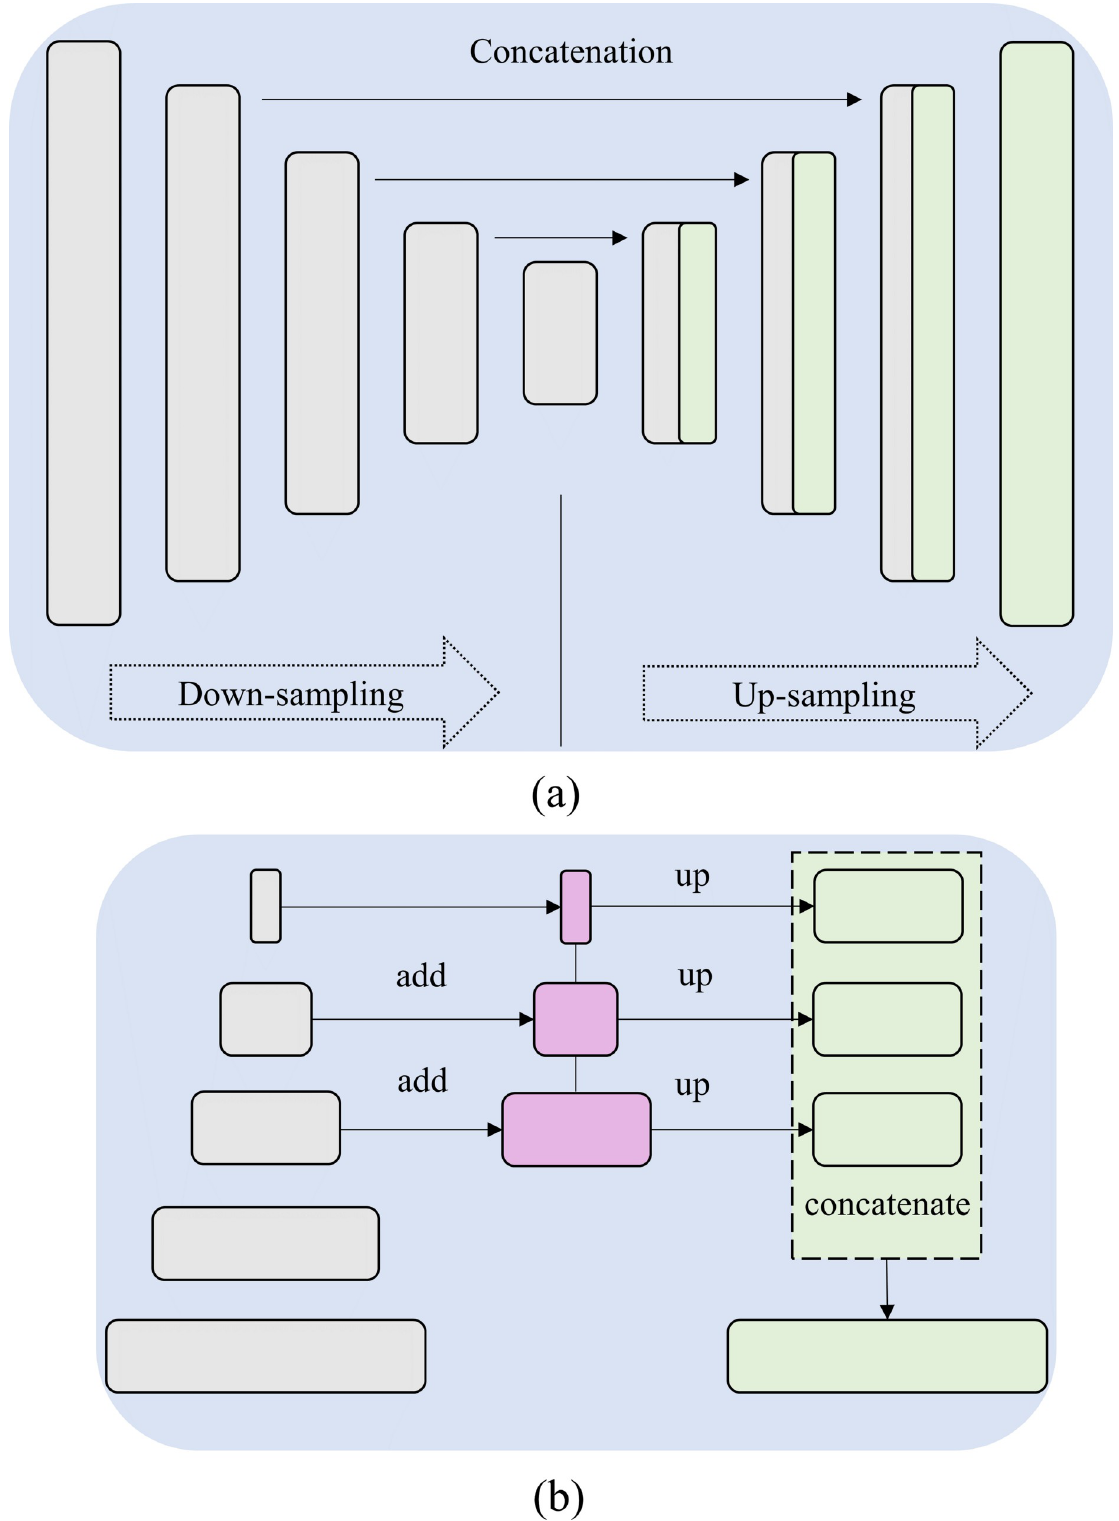
Fig 4. The general architecture of the (a) U-Net and (b) FPN model. The input is a three-channel CXR image. The following encoder- backbones are used in this study (EfficientNet-B0, ResNet-18, SE-ResNet-18, DenseNet-121, Inception-V3, MobileNet-V2, trained on ImageNet